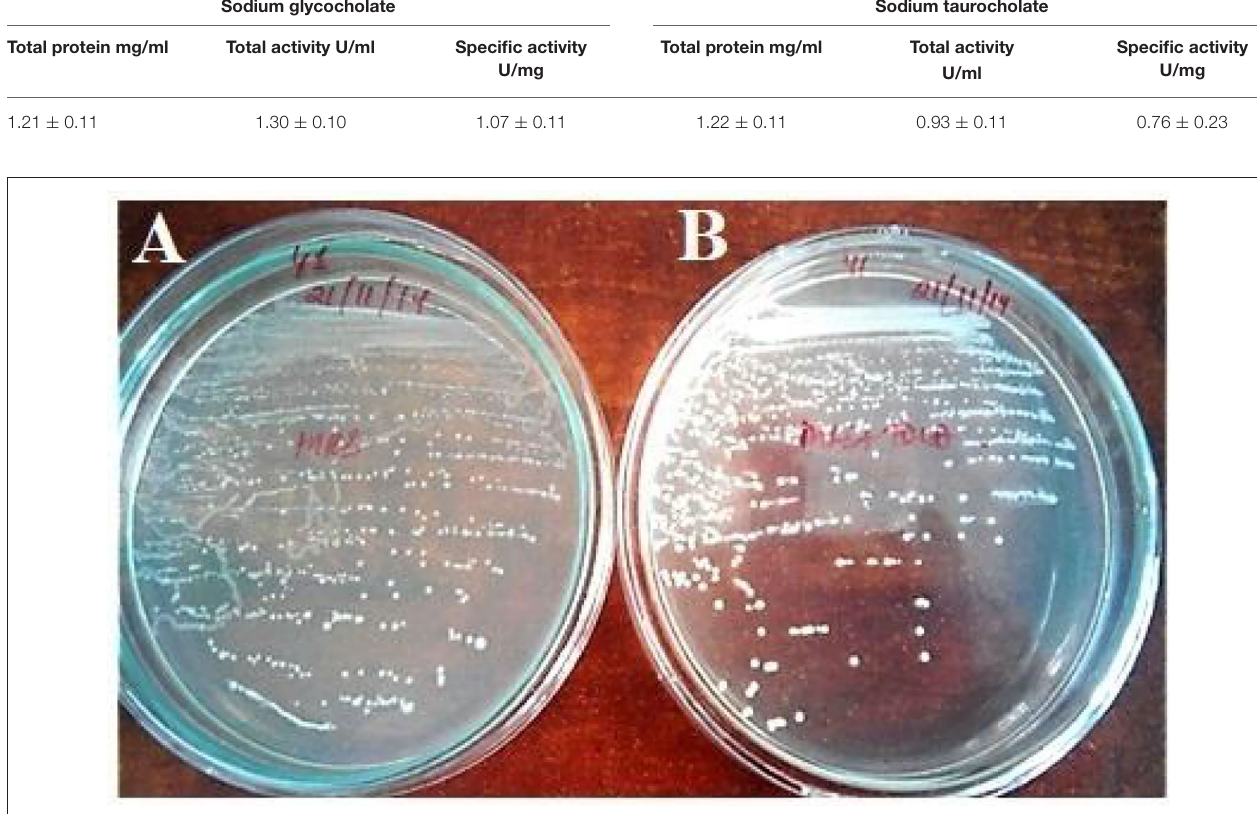
comparison to 6.6 log cycle at pH 2.5 for 2 h. Then, on testing